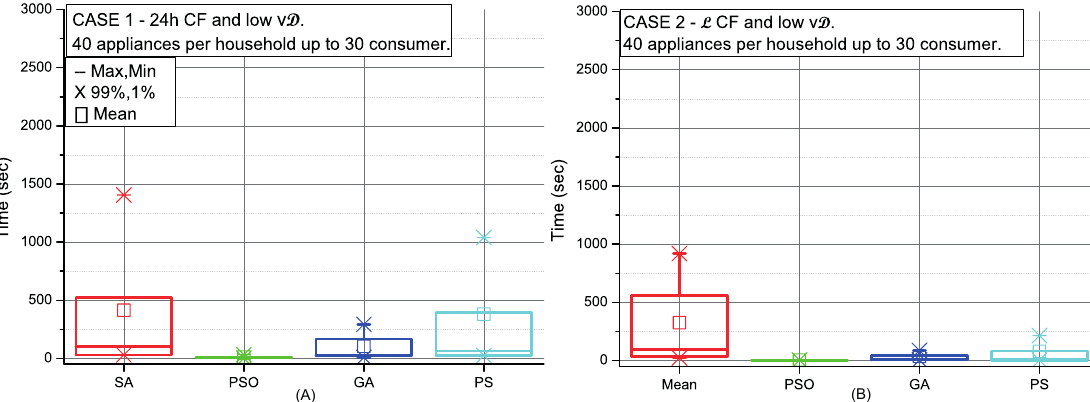
Figure 6. Comparison of the SA, PSO, GA and PS methods for low variable and high fixed consumption in 24 h CF ( A ) and L CF ( B